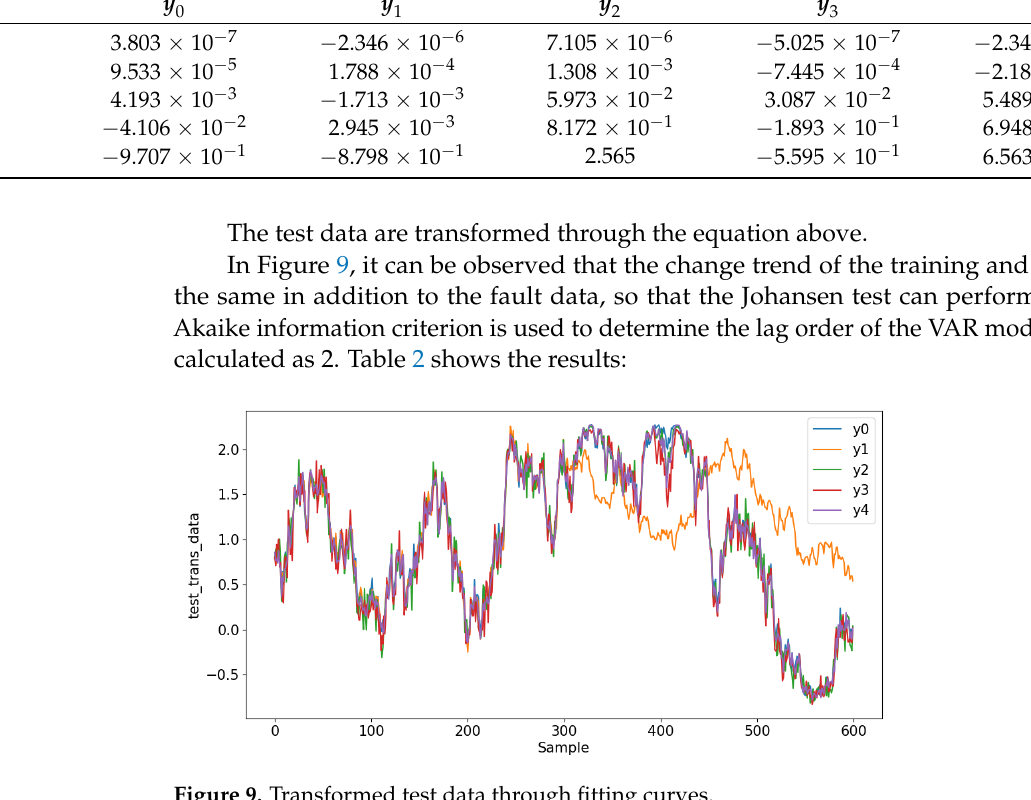
Figure 9. Transformed test data through fitting curves. Table 2. Johansen test results with